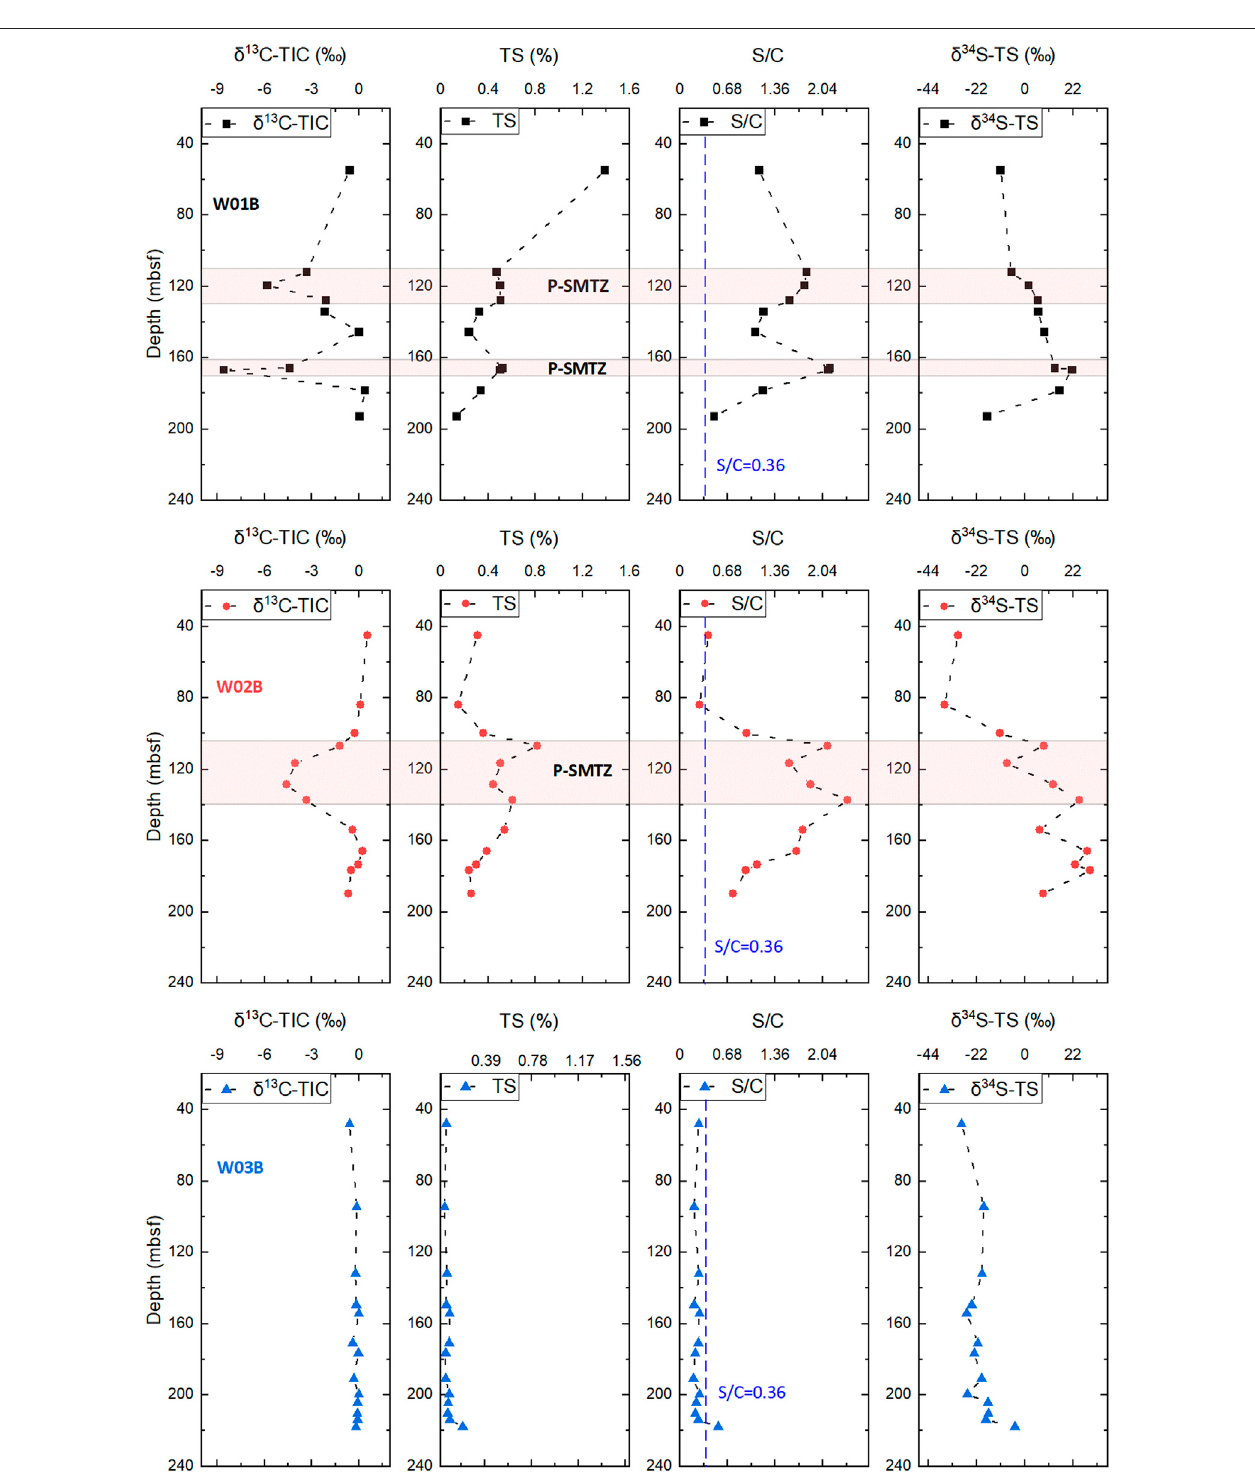
FIGURE 3 | Depth pro fi les of δ 13 C-TIC, TS, S/C ratio, and δ 34 S-TS for W01B, W02B, and W03B from the Shenhu area, SCS. The pink shaded areas imply the possible P-SMTZ.